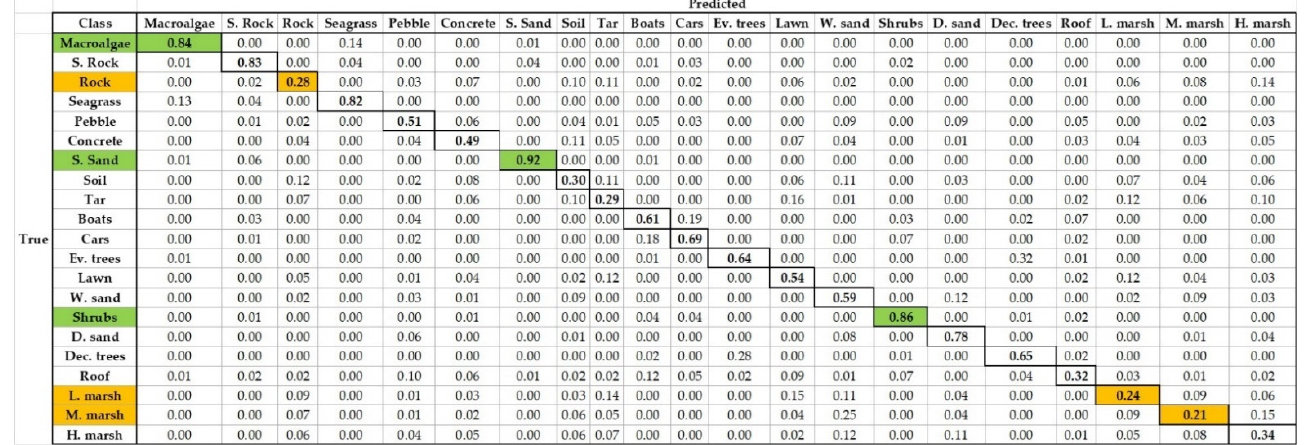
Figure A4. Confusion matrix obtained by the random forest classification of the green waveforms’ features. The three highest and three lowest class accuracy values are highlighted in green and orange, respectively. S. = submerged, Ev. = evergreen, Dec. = deciduous.